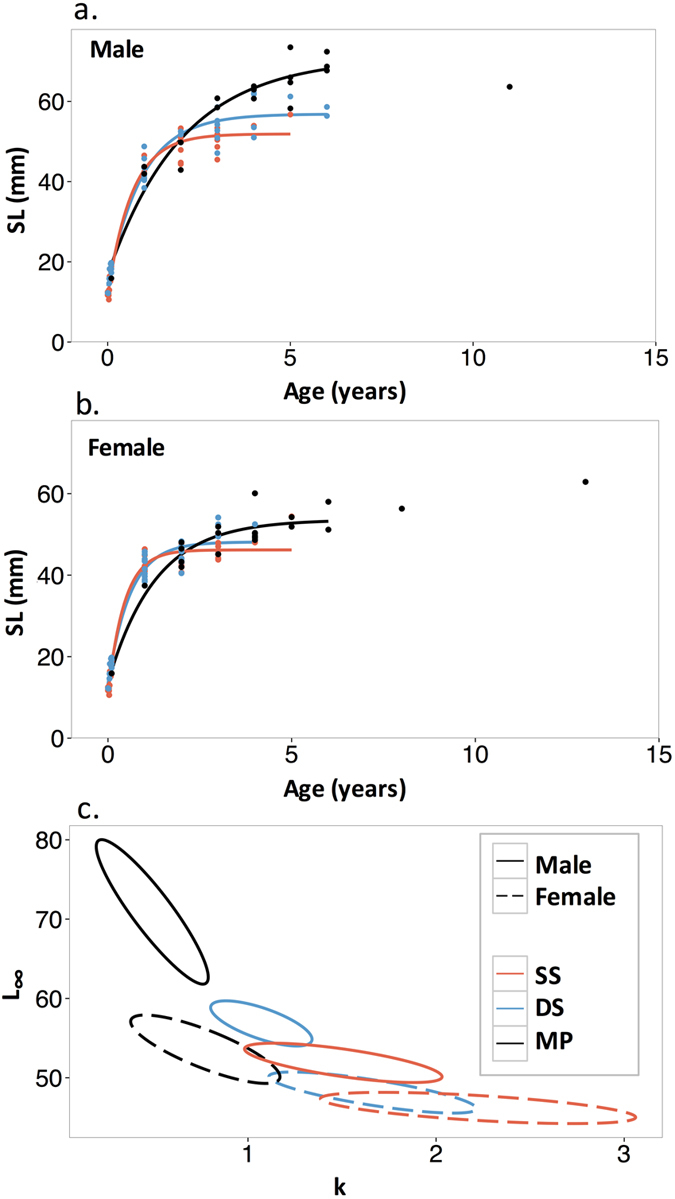
Von Bertalanffy growth model fit for (a) male and (b) female Stegastes partitus and (c) bivariate 95% confidence ellipses for model parameters (L∞ and k) using otolith-derived age and standard length (SL: mm) data from shallow shelf (SS), deep shelf (DS), and mesophotic (MP) depth strata. Stegastes partitus up to 6 yrs old were included in model fits based on the maximum age at SS and DS strata, thus curves only extend to 6 yrs. MP fish >6 yrs old are included in the plot, but were treated as outliers in model fitting. Statistical results are presented in detail in Table 1 and Supplementary Table S1.